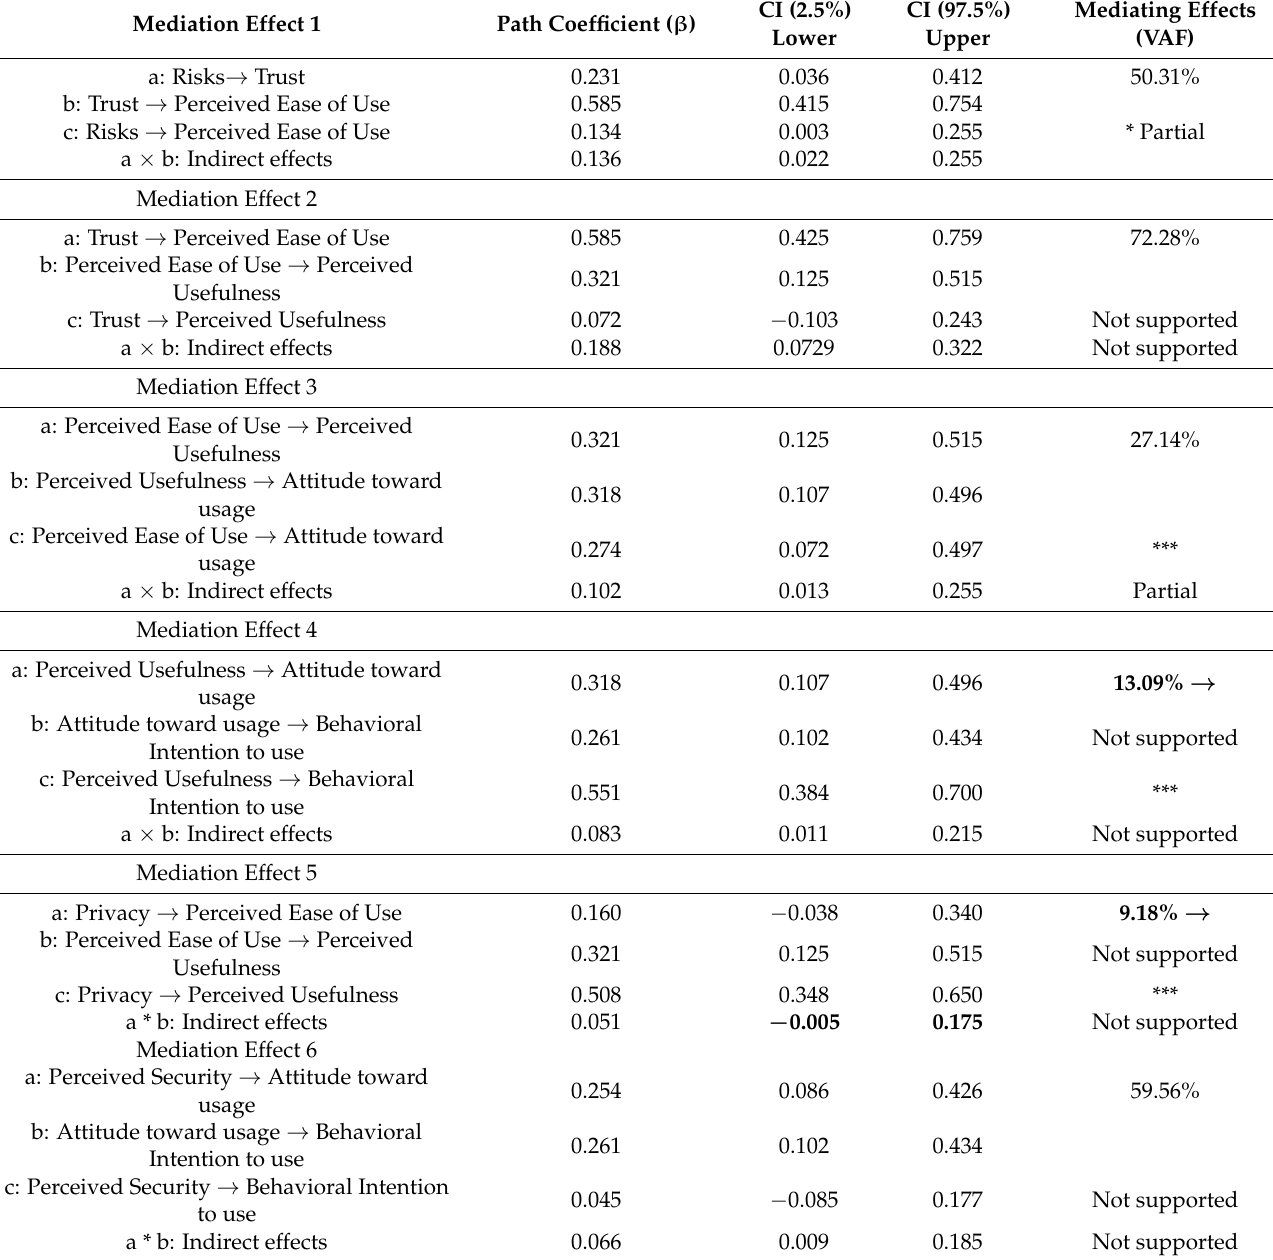
Table 7. Mediating effects. CI—confidence interval; VAF—variance accounted